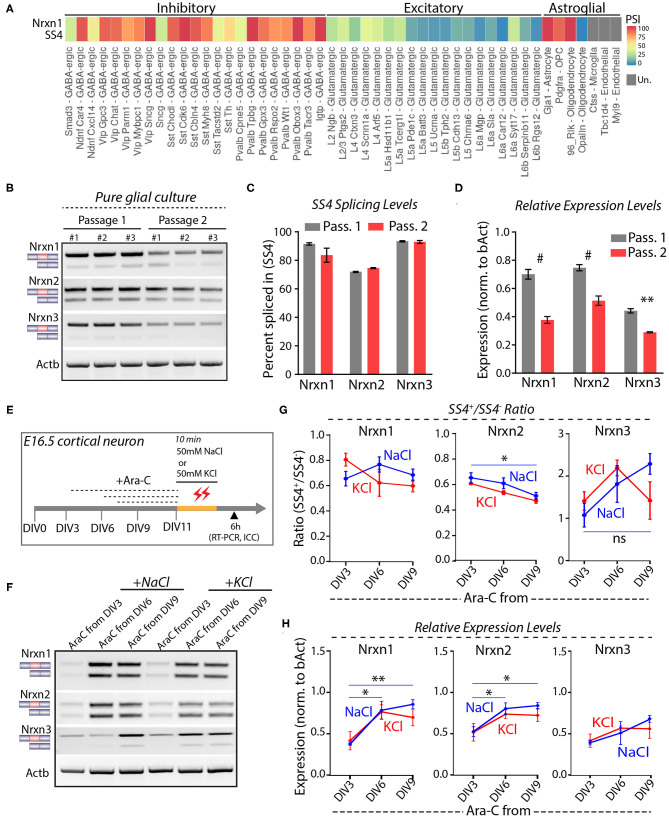
Neuronal and astroglial cells have differential Nrxn SS4 splice pattern. (A) ASCOT single cell RNA-seq data (http://ascot.cs.jhu.edu/) from V1 cortex show differential PSI of Nrxn1 SS4 in inhibitory, excitatory neurons, and astroglial cell populations. PSI, Percent Spliced in. Un - undetected. (B) RT-PCR shows Nrxn SS4 splice pattern in cells from pure glial culture. Three replicates from two passages shown. (C) Quantification of Nrxn SS4 percent spliced in show almost 100% of Nrxn1 and Nrxn3 SS4 spliced-in in glial cells. (D) Relative expression levels of all Nrxns in pure glial cells from passage 1 and 2 (# = p < 0.0001, ** = p 0.0026). (E) Experimental paradigm. Cultured cortical neurons isolated from E16.5 mouse embryos were treated with Ara-C from indicated DIV. At DIV11, cells were exposed to high-KCl or NaCl for 10 min and samples were collected after 6 h for RT-PCR and ICC. (F) RT-PCR shows Nrxn SS4 splicing in various Ara-C treatment regimens with NaCl and KCl treatments. (G) Quantification of splicing ratio shows dynamic change in Nrxn2 and Nrxn3 SS4 splicing between early and late AraC treated control (NaCl) groups. No change in splicing ratio between NaCl and KCl treated cells within specific Ara-C treatment regimens (* = p 0.0357, ns = not significant). (H) Quantification of relative expression show dynamics of Nrxn1 and Nrxn2, but not Nrxn3 between early and late Ara-C treated control (NaCl) groups. No change in expression levels between NaCl and KCl treated cells within specific Ara-C treatment regimens (* = p 0.0153, ** = p 0.0054, Nrxn1; * = p 0.039, DIV3 vs. DIV6; p 0.0204, DIV3 vs. DIV9). All numerical data are represented as means ± SEM. Statistical significance was calculated by two-way ANOVA using Sidak's multiple comparison test.